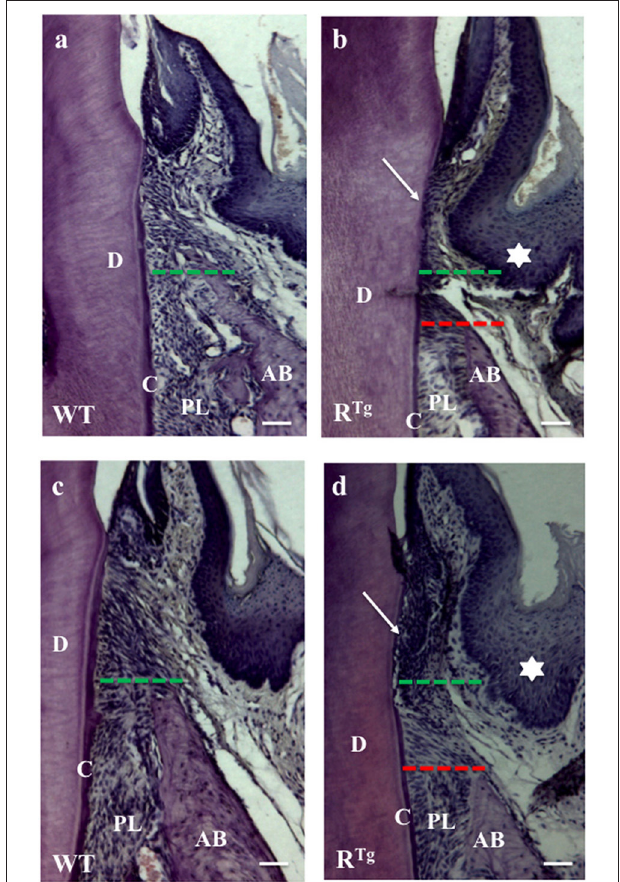
FIGURE 3 | Hematoxylin-Eosin staining of alveolar bone and gingival epithelium. Frontal sections were cut in the molar plane 5 and 6-month-old WT (a,c) and RTg (b,d) mice, and a gradual reduction of the alveolar bone height was detected (green and red lines). This reduction was associated with the detachment and disruption of the epithelial junction (arrows in b,d ). We also observed thickening of the gingival epithelium in R Tg mice (stars in b,d ). AB, alveolar bone; D, dentin; C, cementum; PL, periodontal ligament. Scale bars correspond to 20 µ